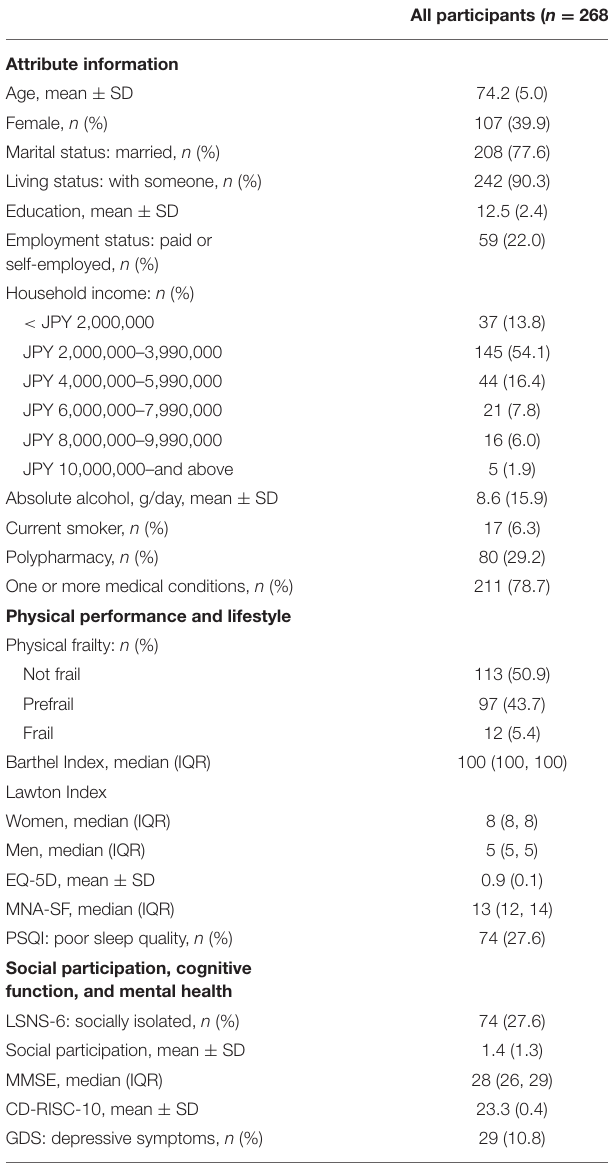
TABLE 1 | Demographic characteristics and comprehensive geriatric assessment results.